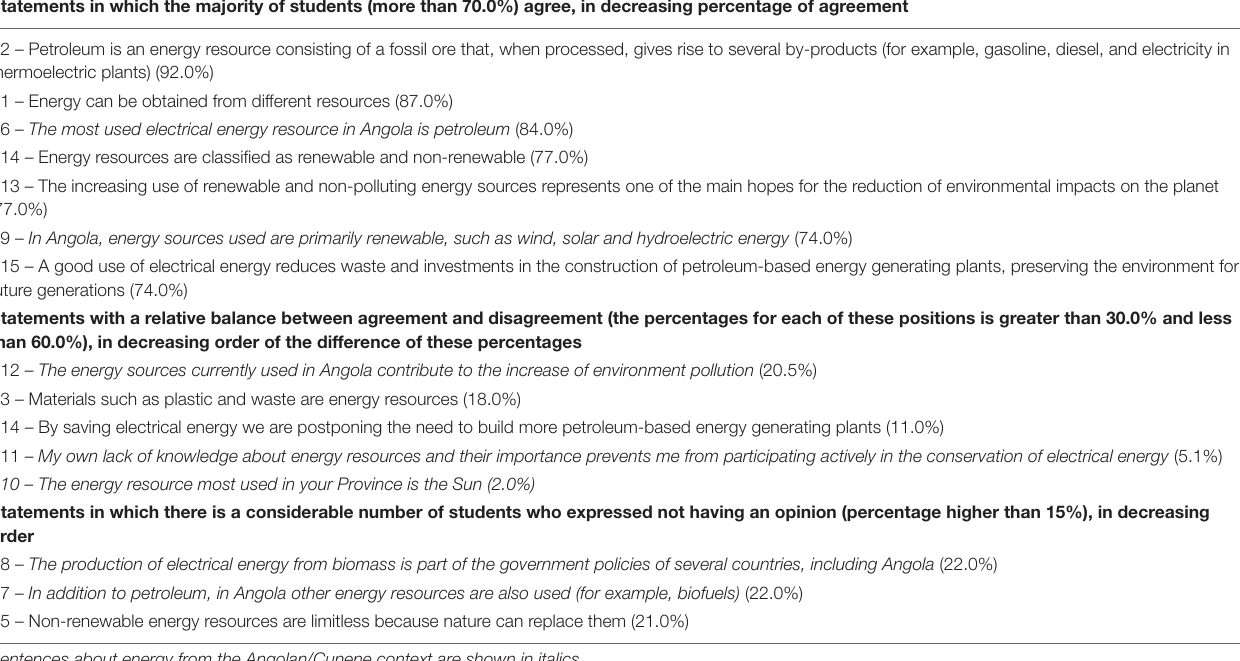
TABLE 2 | Students’ positions toward sentences from the questionnaire about energy in general and in the Angolan/Cunene context. Statements in which the majority of students (more than 70.0%) agree, in decreasing percentage of